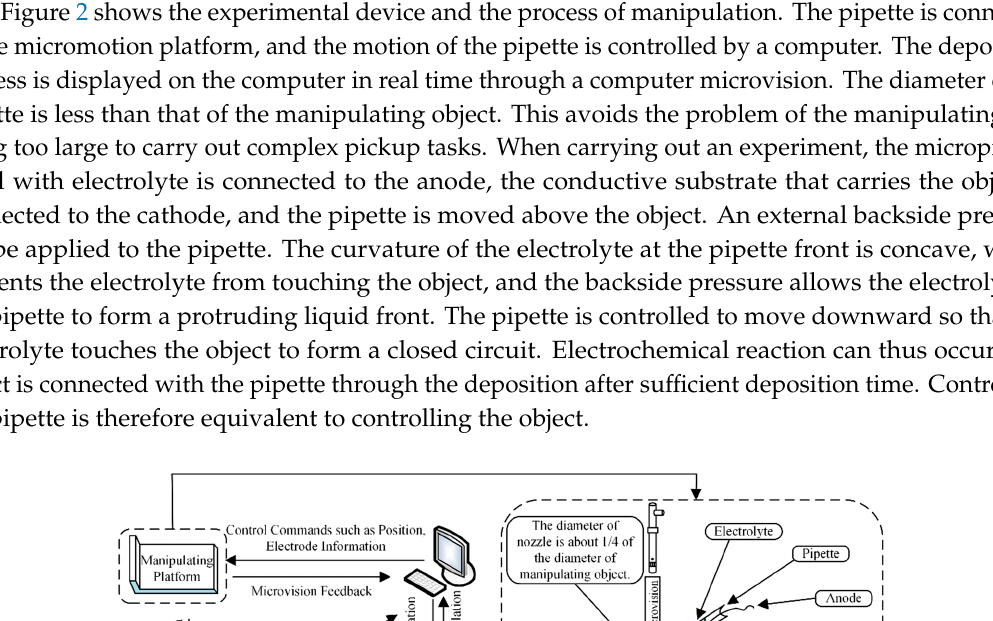
Figure 1. Diagram of the proposed manipulation method.